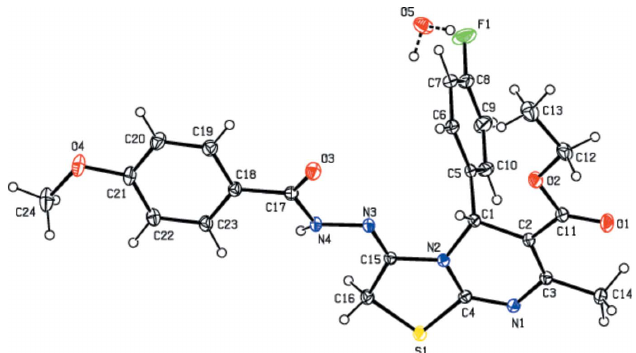
Figure 1 The title molecule with the labelling scheme and displacement ellipsoids drawn at the 30% probability